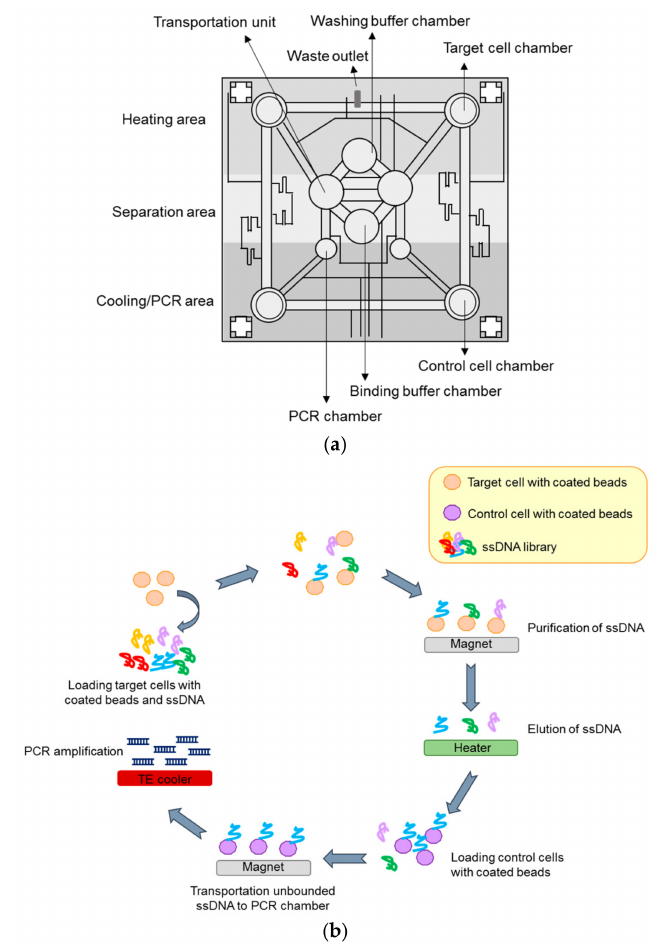
Figure 6. ( a ) Schematic representation of the magnetic-bead-based microfluidic chip used in microfluidic-based cell-SELEX procedure; ( b ) Fundamental steps of the procedure. Aptamers are mixed with magnetic beads-coated target cells (positive selection) and the magnetic-bead complexes are recovered by applying a magnetic field. Bound ssDNAs are then mixed with magnetic beads-coated control cells (negative selection). Control cells–aptamer complexes are collected and the supernatant are transported to the PCR chamber for